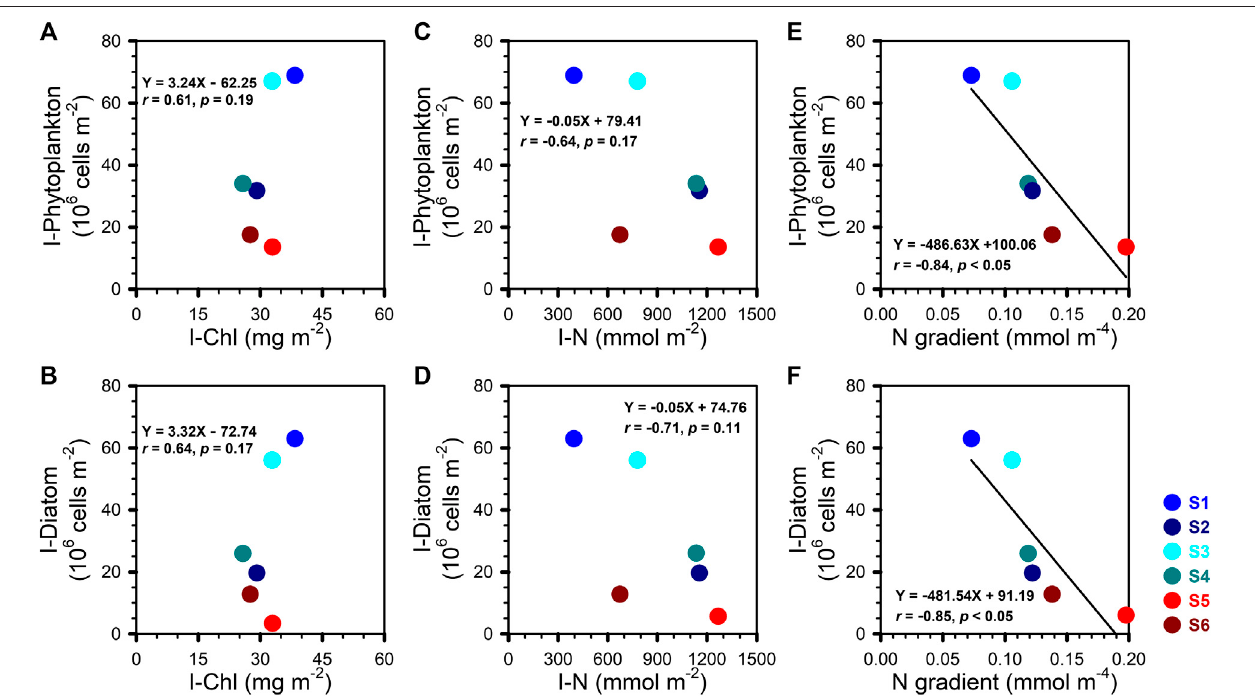
FIGURE5| I-PhytoplanktonandI-Diatom vs. (A , B) I-Chl; (C , D) I-N; (E , F) Ngradientbetweenthelowerboundaryofthemixedlayerand150 m.ThelinesintheE and F denoted the result of linear regression.